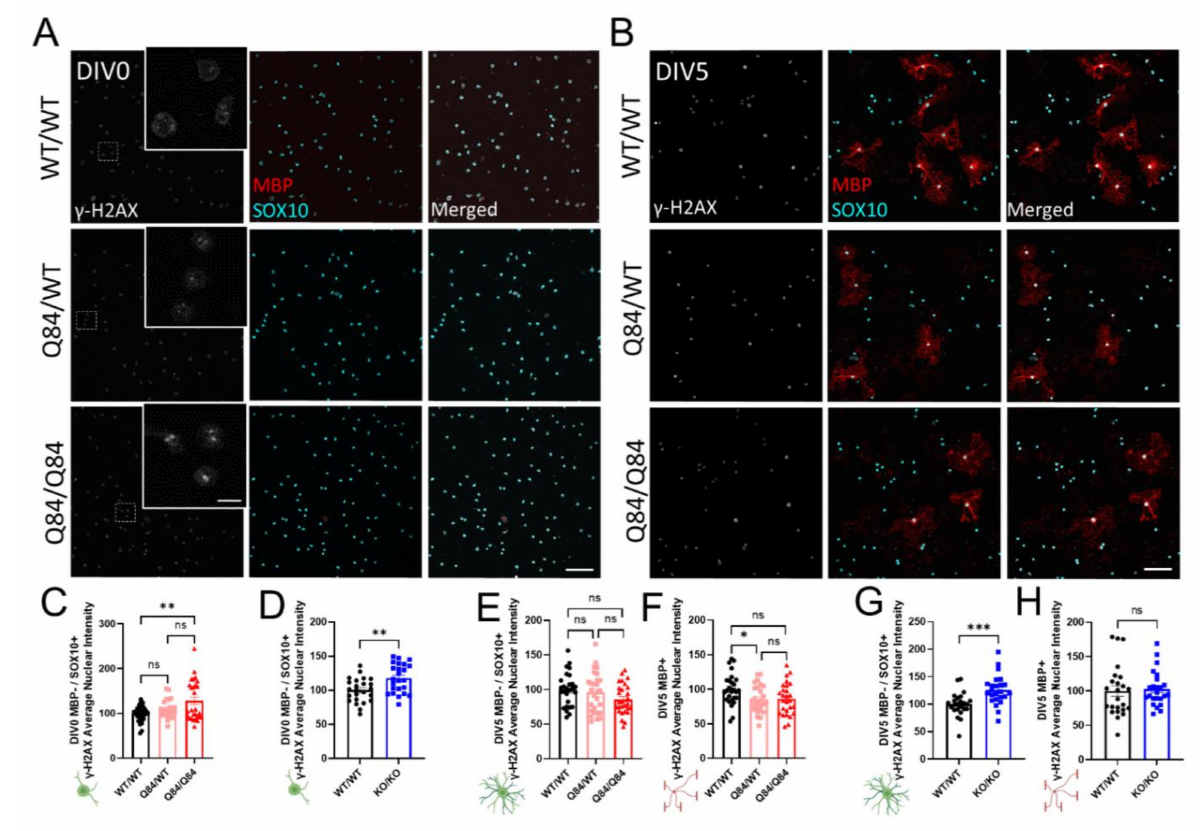
Figure 4. DNA damage signaling does not correlate with SCA3 oligodendrocyte maturation impair- ments, but may increase with cellular stress. ( A , B ) Representative immunofluorescent images of nuclear DNA damage marker γ -H2AX (white), mature oligodendrocyte marker MBP (red), and pan- oligodendrocyte marker SOX10 (cyan) expression in cultured WT/WT, Q84/WT, and Q84/Q84 oligo- dendrocytes at DIV0 ( A ) and DIV5 ( B ). Scale bar 100 µ m, inset scale bar: 12.5 µ m. ( C , D ) Quantification of nuclear γ -H2AX in DIV0 OPCs. Nuclear γ -H2AX intensity at DIV0 is increased in Q84/Q84 oligo- dendrocytes relative to WT ( C ) and Atxn3 -KO oligodendrocytes relative to WT ( D ). ( E – H ) Quantifi- cation of nuclear γ -H2AX in immature (MBP − /SOX10+) and mature (MBP+) oligodendrocytes at DIV5. Nuclear γ -H2AX intensity is not significantly changed in immature diseased oligodendrocytes ( E ), nor in Q84/Q84 mature oligodendrocytes relative to WT. Loss of ATXN3 leads to changes in γ -H2AX nuclear expression only in immature oligodendrocytes ( G ), but not mature cells. Intensity quantifications normalized to averaged WT/WT images (n = 4–8 images per mouse, n = 3–5 mice